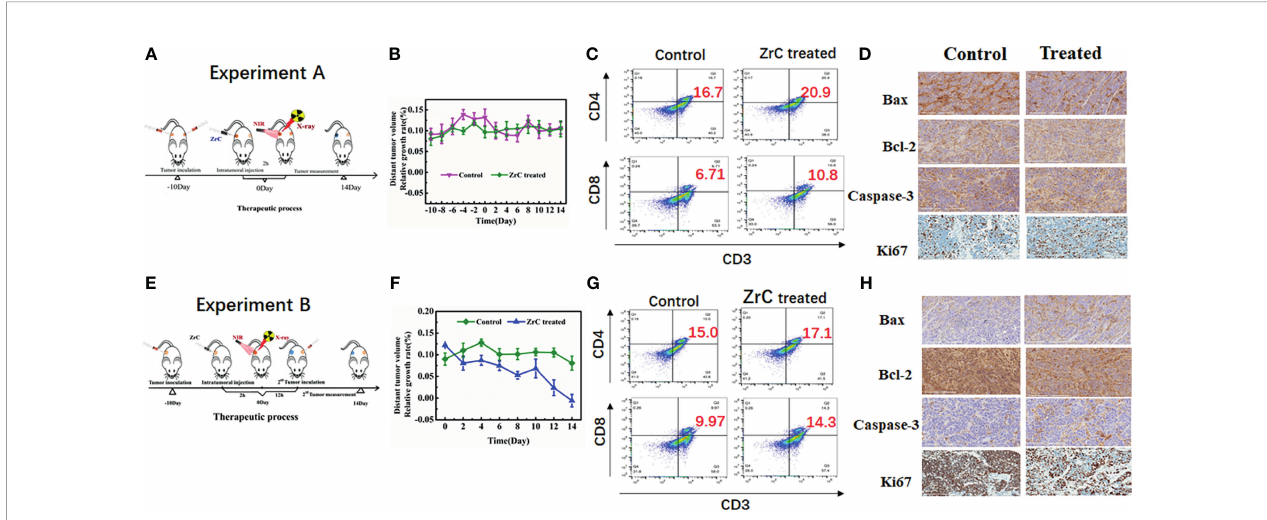
FIGURE 6 | (A, E) Schematic illustration of A/B experiment design and measure the distant tumor volume. (B, F) Relative growth rate of distant tumor volume in two groups. Error bars represent mean ± SD. (C, G) Representative fl ow cytometry plots showing different types of T cells in tumor tissue from different groups of mice. (D, H) Immunohistochemical analysis of tumor